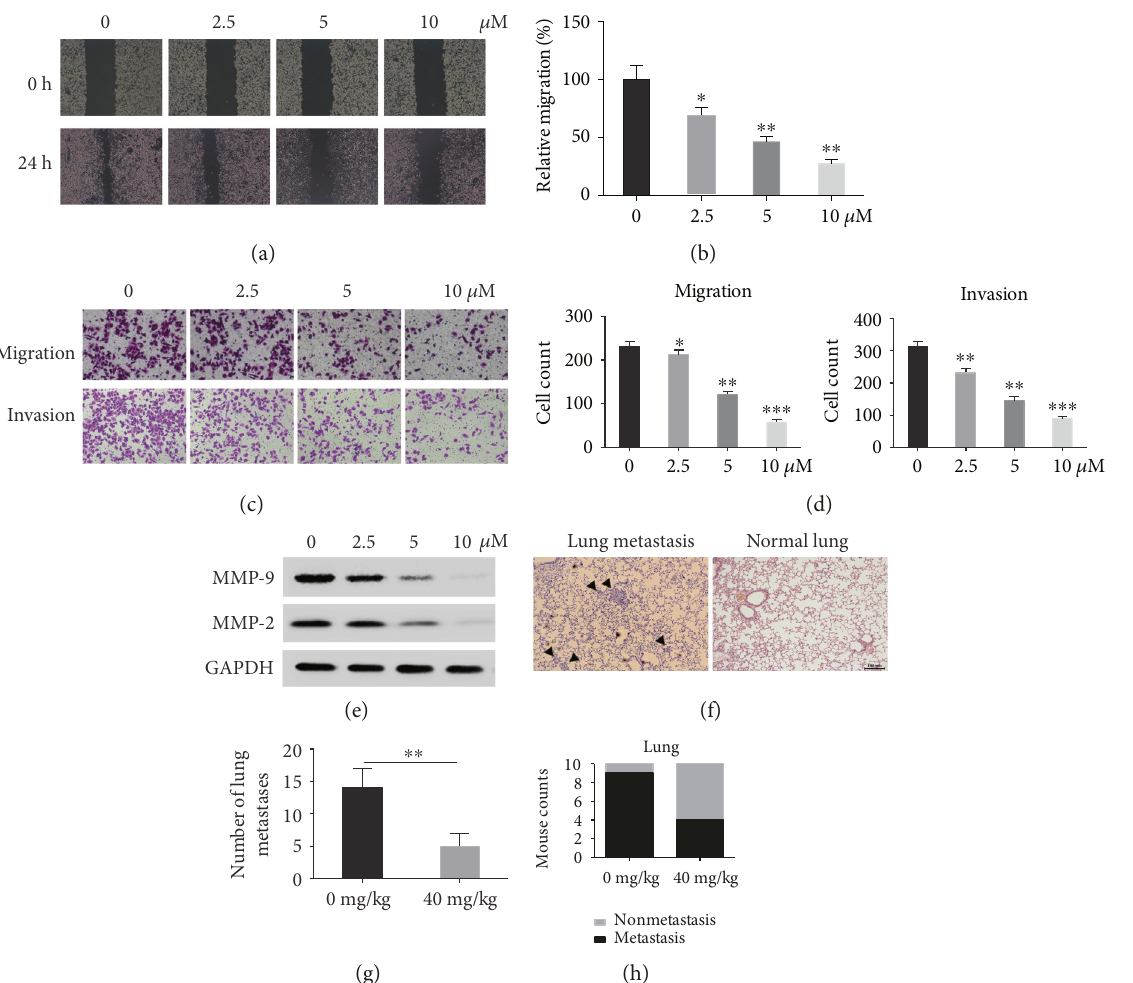
Figure 3: Aloesin inhibits cell migration and invasion in SKOV3 cells. (a) Wound healing assay was performed to observe the e ff ects of aloesin treatment on SKOV3 cell wound recovery ability. (b) Quanti fi cation of the healed wound area. (c) Transwell migration and invasion assays were performed to observe the e ff ects of aloesin treatment on SKOV3 cell migration and invasion abilities. For each group of cells, fi ve fi elds were randomly photographed and representative images were shown here. (d) In the transwell migration and invasion assays, transmigrated cells were counted from the photographed 5 fi elds in each group. The average cell numbers were calculated in each group. (e) Western blot analysis of major matrix metalloproteinase MMP-2 and MMP-9 expression in SKOV3 cells with distinct doses of aloesin. ∗ p < 0 05 ; ∗∗ p < 0 01 ; ∗∗∗ p < 0 001 . (f) Representative photos of histological H&E staining of lung metastasis were shown for each group. (g) A bar graph summarizes the number of lung metastasis node in the two groups. (h) A bar graph summarizes the incidence of lung metastasis in the two